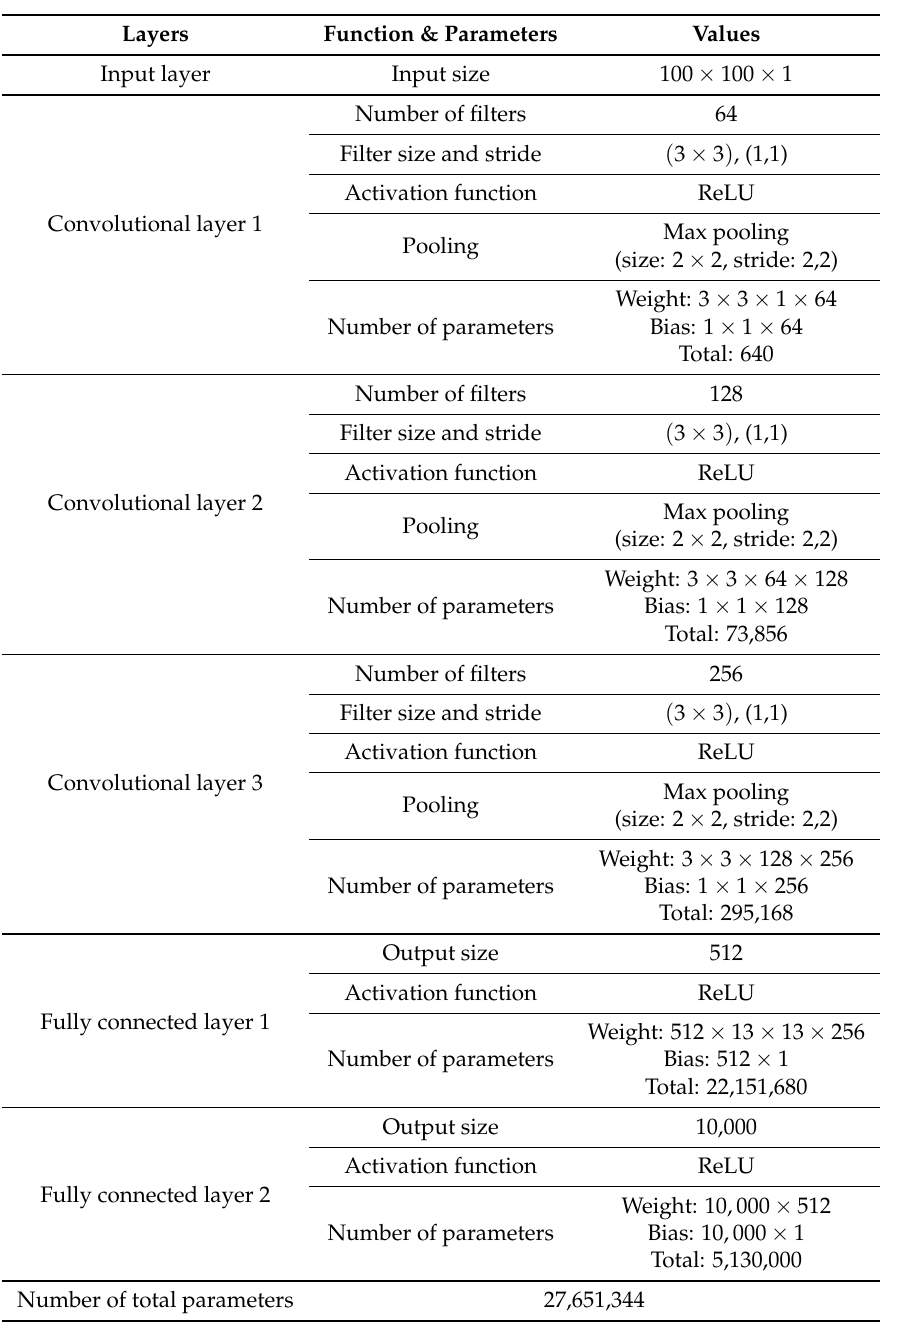
Table 1. Proposed CNN and its